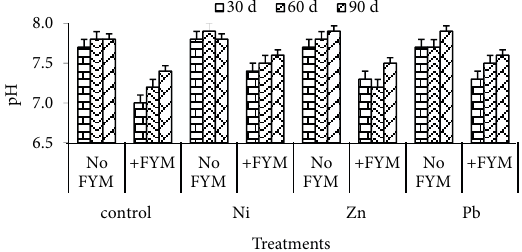
6.57.07.58.0 Fig. 1. Effect of FYM addition on soil pH at different incubation times. [FYM – farmyard manure]